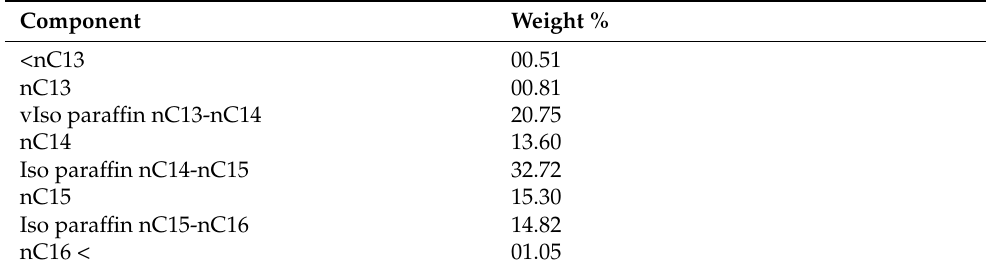
Table A1. Composition of white mineral oil (#5).